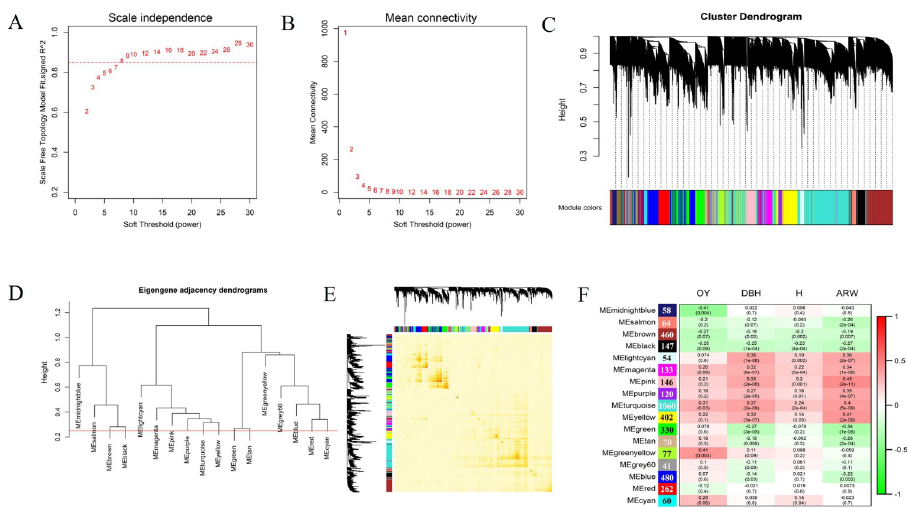
Fig 6. Construction of gene co-expression networks with WGCNA. A B Soft threshold ( β value) determination that makes the network close to scale-free; the red dotted line is drawn at 0.85. C The genes were clustered, and then the tree was clipped into different modules using the dynamic shearing method (the minimum number of genes in the module was set to 30). D Eigengene cluster tree. The module below the red line (at 0.2), which indicates correlation > 0.8, was merged in the next step. E TOM map. The rows and columns represent individual genes, and deep yellow and red represent high topological overlap. F Correlation heat map between the modules and four traits. The values in the box represent the correlations and P values. The numbers of genes in the modules are shown as the different colored boxes.